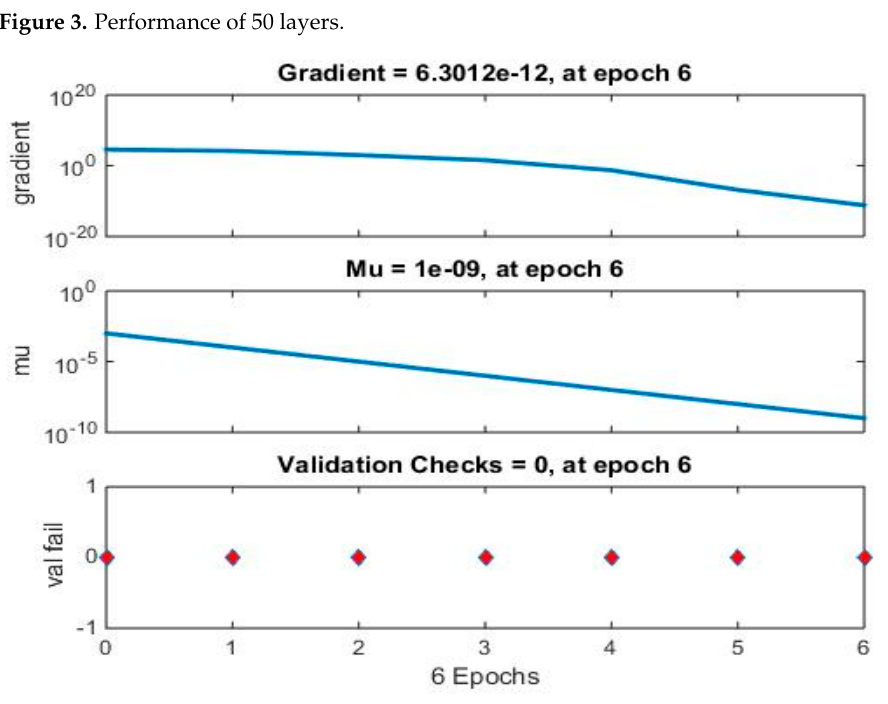
Figure 3. Performance of 50 layers.